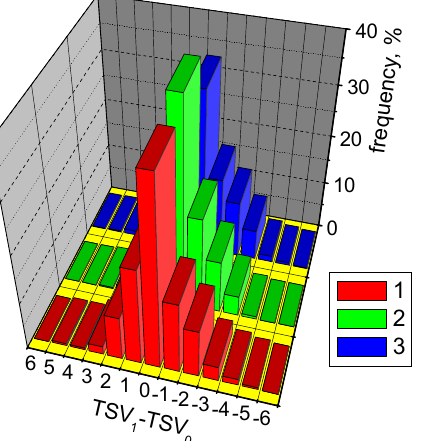
19 of 26 Figure 15. Thermal acceptability vote vs. thermal preference vote—data for all the buildings, the red line represents the approximation curve, while the purple dots the average values of TAV. Figure S3 in the Supplementary Material presents the confidence bands for the mean (CI) and the prediction (PI) that correspond to the regression presented in Figure 15. The identified quadratic predicting model for TAV is as follows: 1.200.18TPV +TPV 0.893 –=TAV 2 + , (7) while the R 2 value is 0.62. All the above analyses have been performed on the questionnaires filled in after ca. 1.2 h after the respondents entered the rooms in order to allow for thermal accommoda-